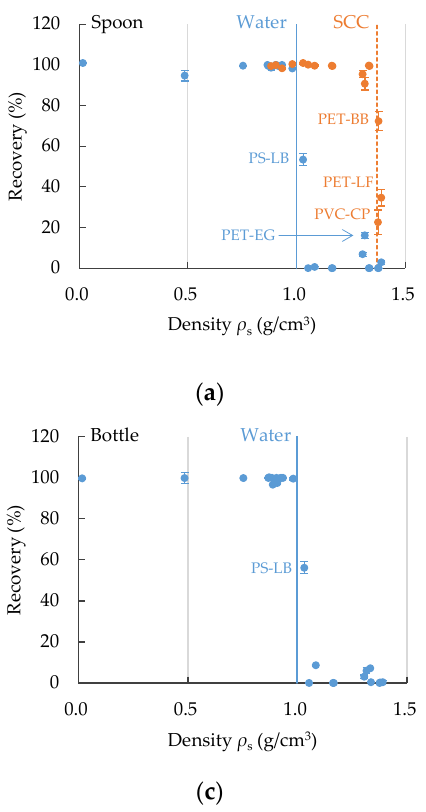
Figure 10. Density ρ s and recovery rate of solid samples (n = 6, mean ± SE): ( a ) spoon method; ( b ) overflow method; ( c ) bottle method. The flotation media were water and SCC solution for the spoon method only.